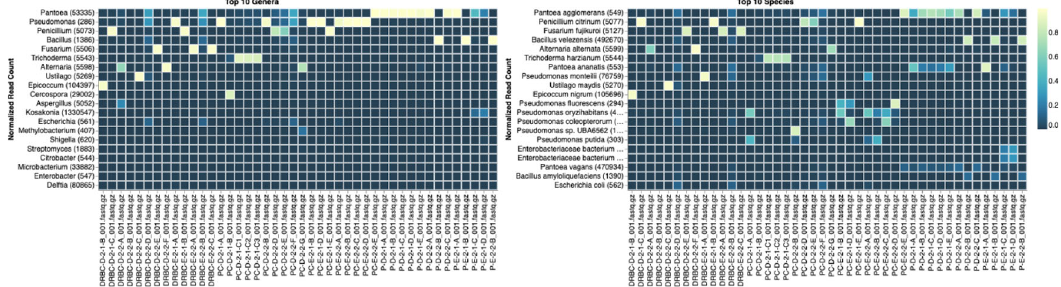
Figure 5. Summary heatmap of colony classification by whole genome sequencing. Sample nomenclature on the X axis describes the media the colonies were isolated from. DRBC prefix = DRBC. PC prefix = PDA with CAMP. P prefix = PDA without CAMP.